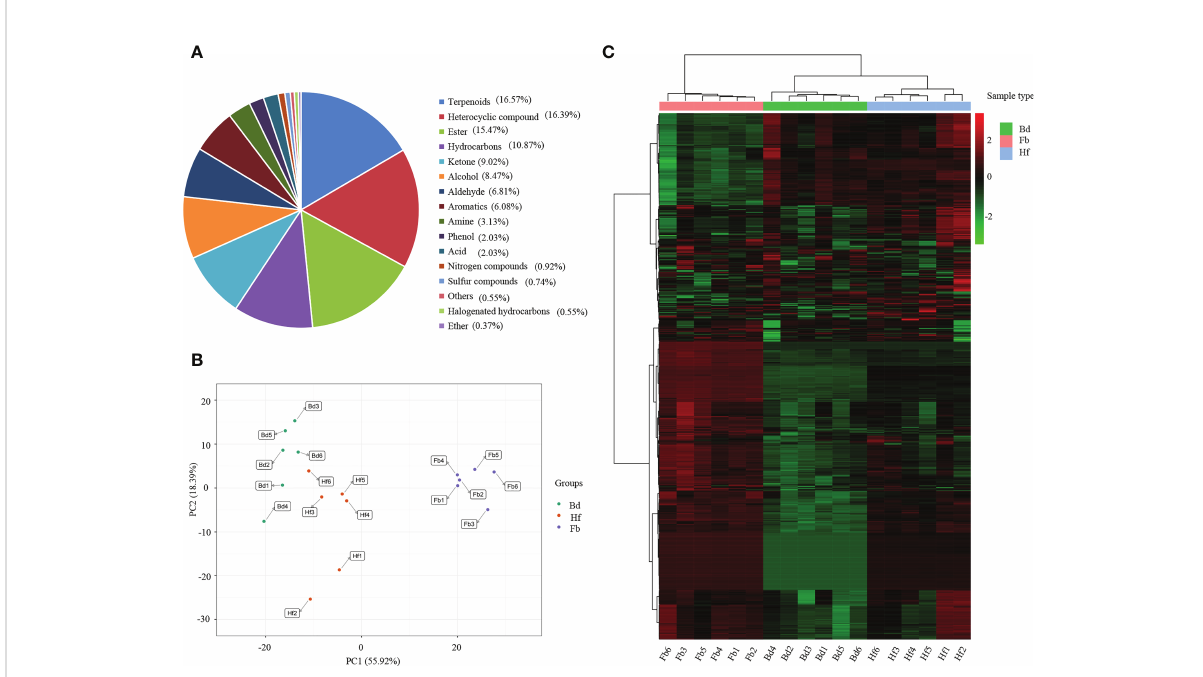
FIGURE 2 (A) Classi fi cation and proportion of total 543 volatile organic compounds (VOCs) detected in fl owers of D. chrysotoxum ; (B) Principal component analysis (PCA) among samples of D. chrysotoxum fl owers by HS-SPME-GC/MS at different fl owering stages; (C) Hierarchical clustering heatmap of VOCs accumulation of D. chrysotoxum fl